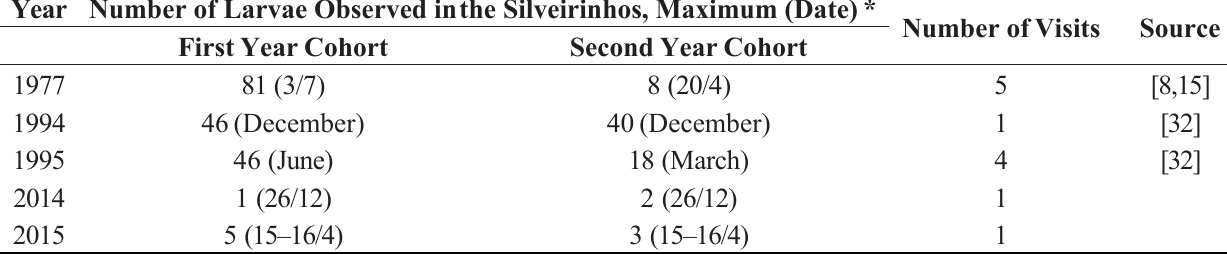
Table A2. Silveirihos brook.